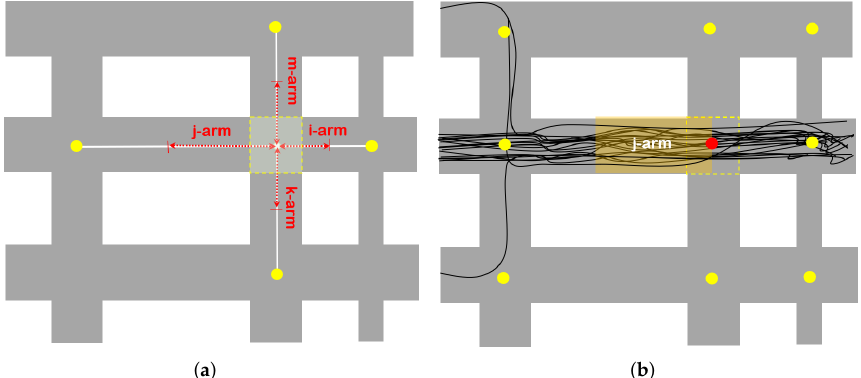
Figure 8. Each intersection (yellow dots) is composed from intersection arms, that connect it to nearby intersections (white lines). Classification features are computed per arm, within half the distance of the road segment that connects the current arm with the one previously visited by the trajectory (red dotted arrows in ( a )). For each trajectory (black lines) in ( b ) that crosses the intersection arm j-arm from west to east, stop and deceleration events are computed within the orange indicated area along j-arm